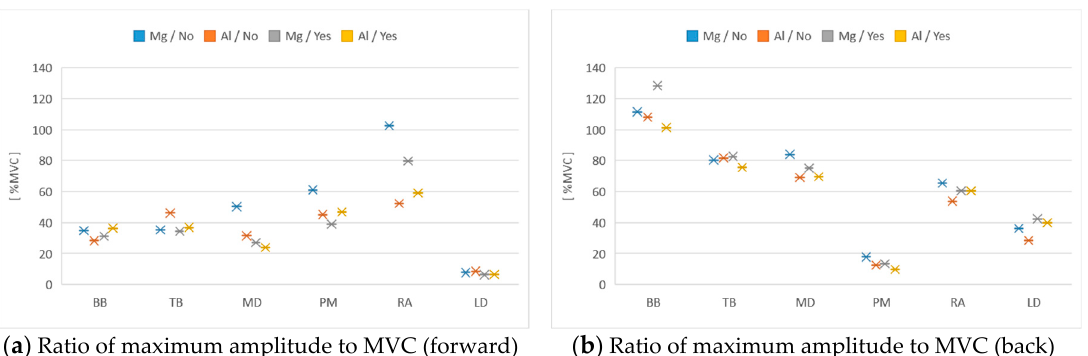
Figure 3. Ratio of maximum amplitude to maximal voluntary contraction (MVC). From the left of each figure, BB, TB, MD, PM, RA, LD and, from the left of each muscle, Mg alloy no racket, Al alloy no racket, Mg alloy racket, Al alloy racket: ( a ) forward stroke; ( b ) back